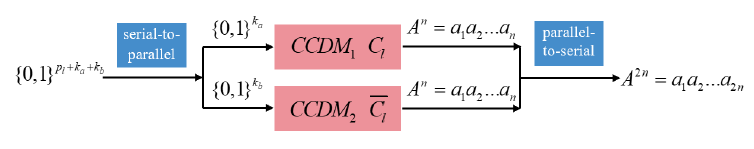
Figure 2. The block diagram of the parallel distribution